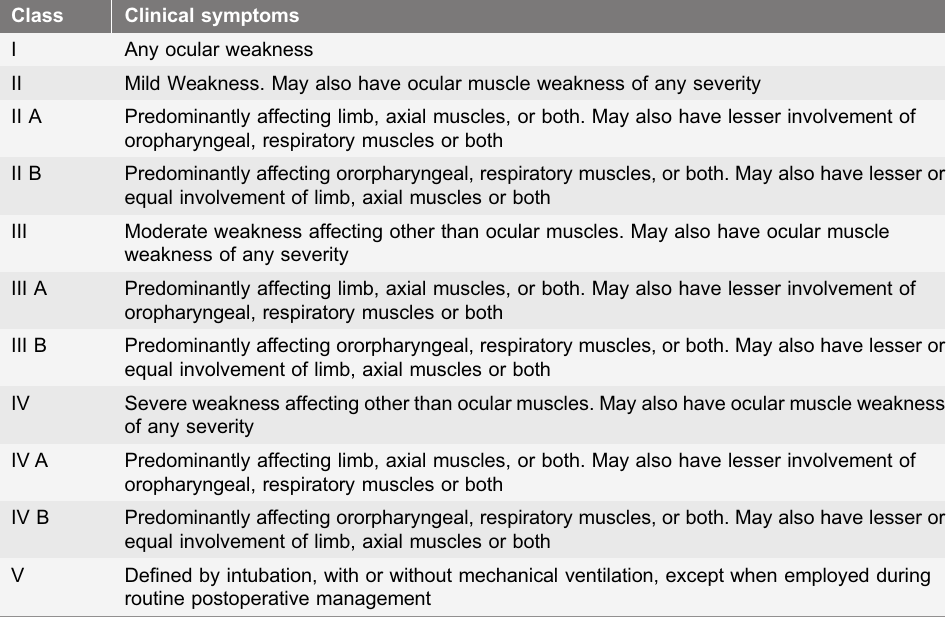
Table 1. Myasthenia Gravis Foundation of America Clinical Classification